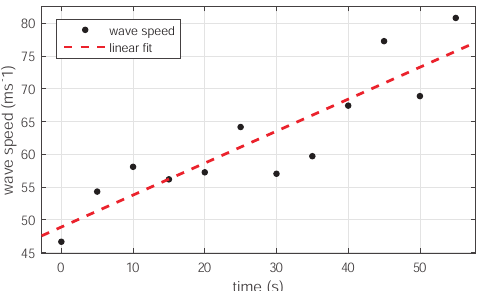
Figure 7. Wave speed c increases linearly with time t, c = At + b , with A = 0 . 49 ms − 2 , b = 48 . 9 ms − 1 , coe ffi cient of determination R 2 = 0.80.